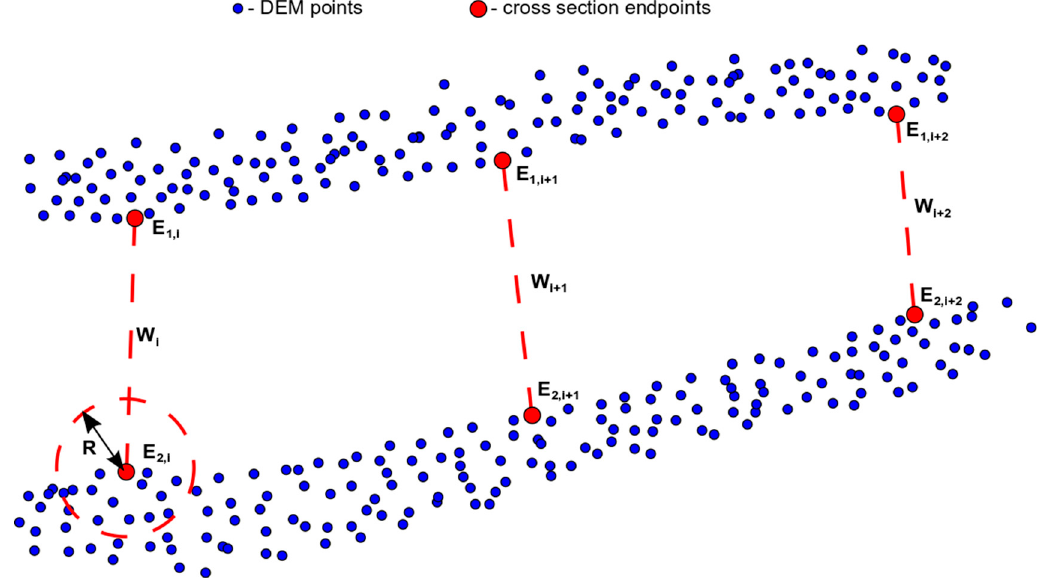
Figure 1. Defining the position of the new cross-sections. (width (W), endpoint (E), lowest point search radius (R)).